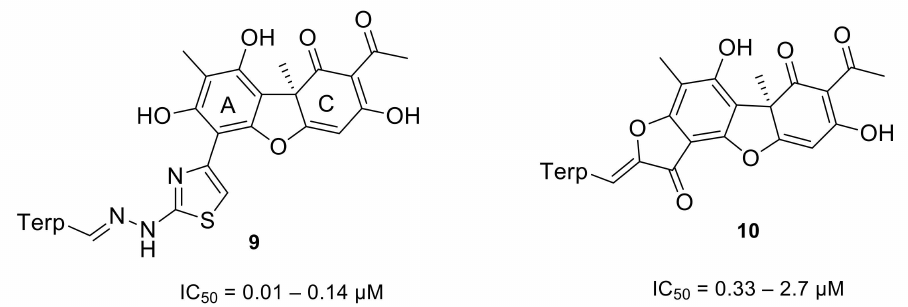
Figure 3. Structures of usnic acid and monoterpenoid conjugates that inhibit